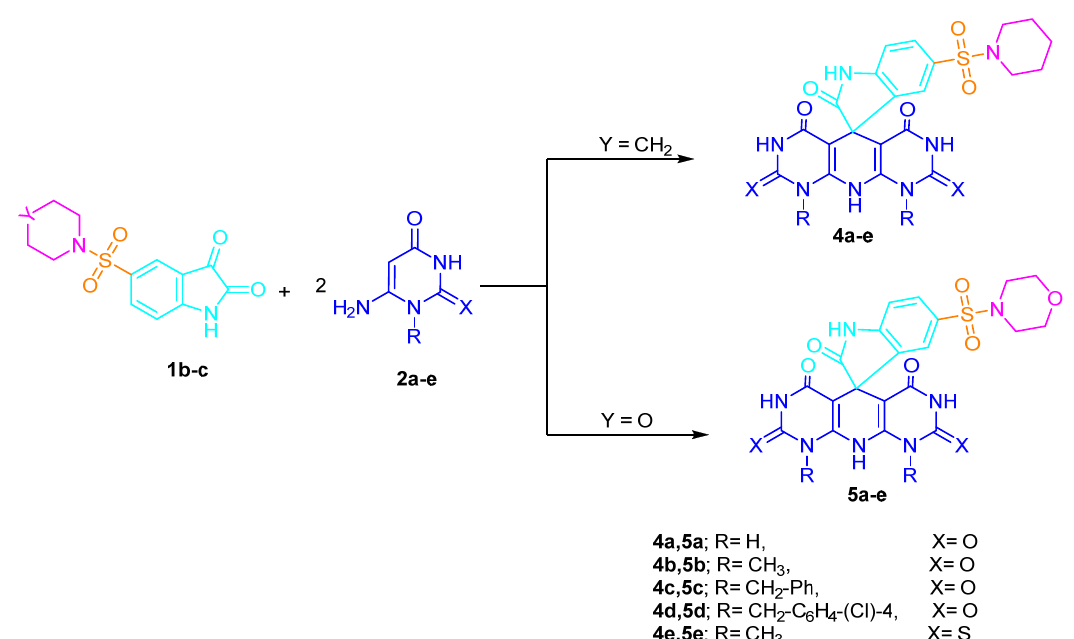
Scheme 2. Illustration of the proposed mechanism for synthesis of spiro–oxindole